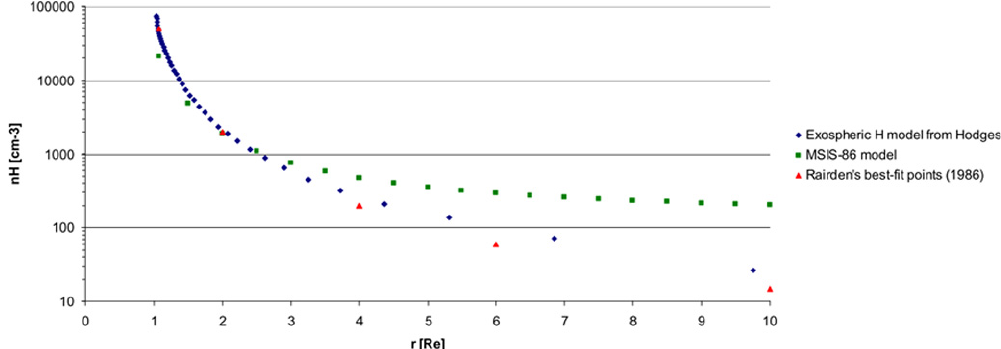
Fig. 10. Hydrogen density with the exospheric H model from Hodges and the MSIS-86 model compared to Rairden’s best-fit points under the conditions of measurements made by DE 1 on 14 October 1981.